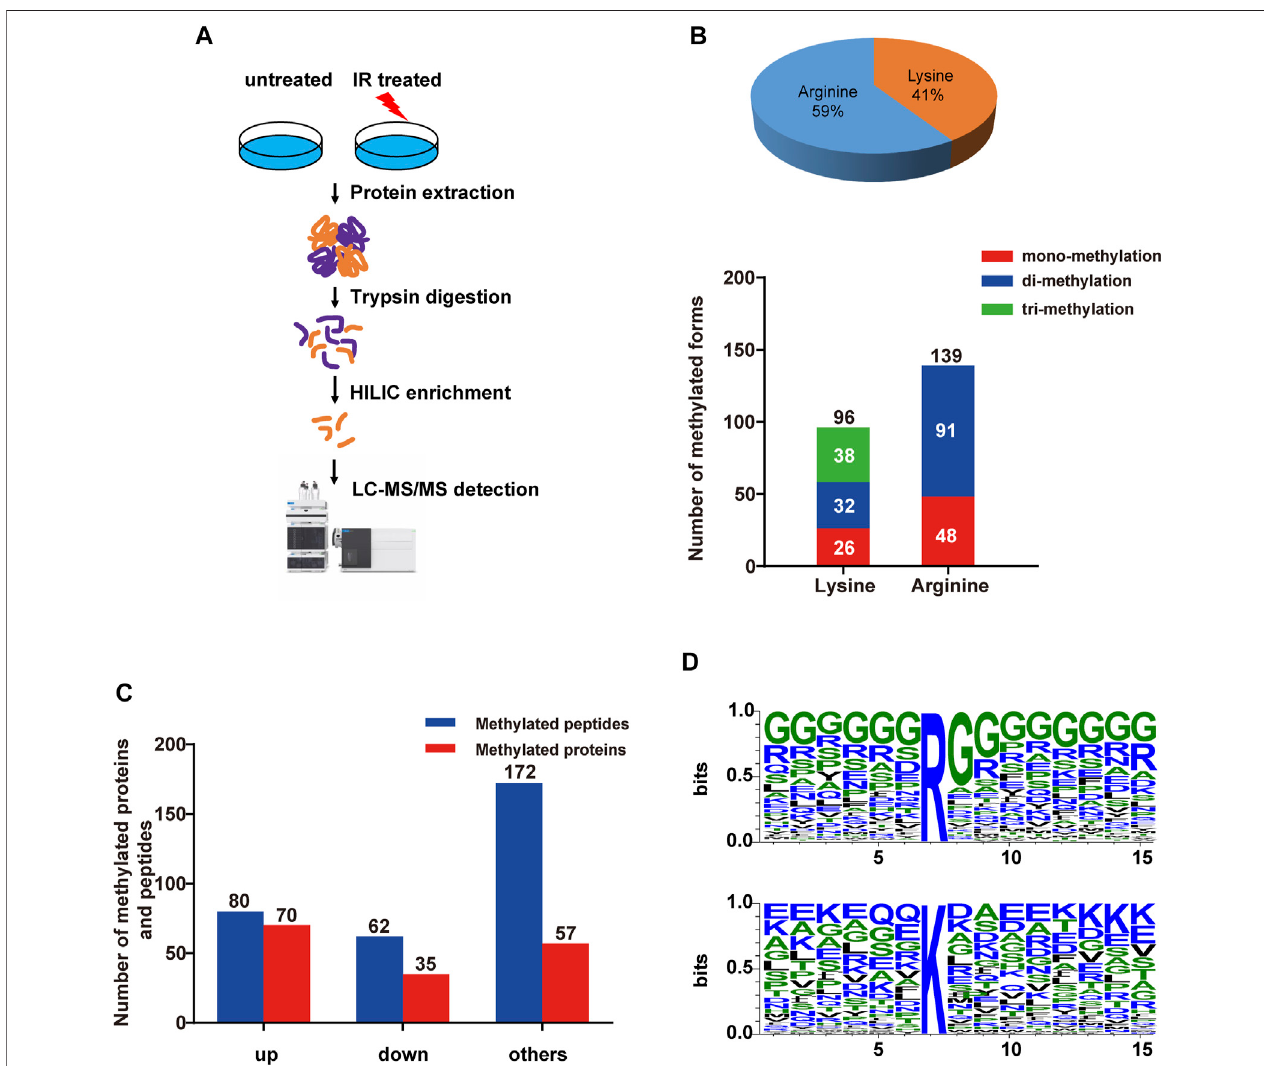
FIGURE 1 | Quantitative overview of methylated peptides and proteins in HEK293T cells upon IR treatment. (A) The strategy for global analysis of protein methylationinresponsetoIRtreatment.HEK293TcellsweretreatedwithIR,andthenproteinsfromcelllysatesweredigestedwithtrypsin.TheHILICtipenrichmentwas processed. Then, large-scale identi fi cation of protein methylation was carried out by LC − MS/MS followed by data analysis and bioinformatics analysis. (B) Number of methylated proteins and peptides quanti fi ed in HEK293T cells in response to IR treatment. Upper panel: ratio of lysine and arginine methylation sites; lower panel: numbers of different methylation forms. (C) Bar plots showing the identi fi ed up- or down-represented (log2-fold change > 1 and < − 1) methylated peptides and proteins upon IR-induced DNA damage. ‘ up ’ , methylated peptides and proteins whose intensities were increased at least 2-fold; ‘ down ’ , methylated peptides and proteins whose intensities were increased at least 2-fold; ‘ others ’ , methylated peptides and proteins whose intensities were changed less than 2-fold. (D) Sequence logo of identi fi ed arginine (R) and lysine (K) methylated sites within − 6 to +8 amino acids, generated with WebLogo. The overall height of each stack indicates the sequence conservation at that position (measured inbits), whereas theheightofsymbolswithin thestack re fl ects the relative frequencyofthe correspondingamino or nucleic acid at that position.